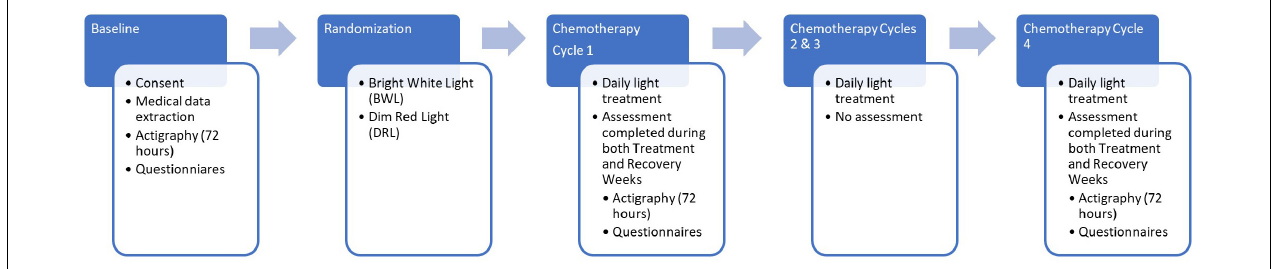
FIGURE 2 | Flow diagram depicting study procedures including timing of actigraphy and questionnaire